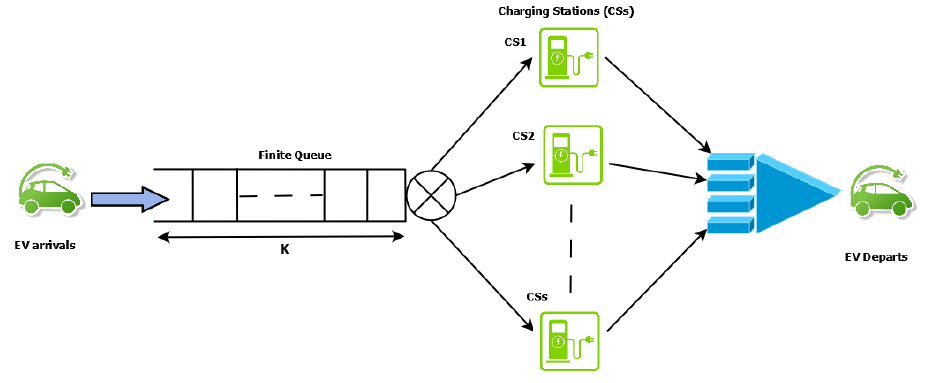
Figure 9. Conceptual Framework of EVs queuing model at Multi-level EV Charging Station Infrastructure.